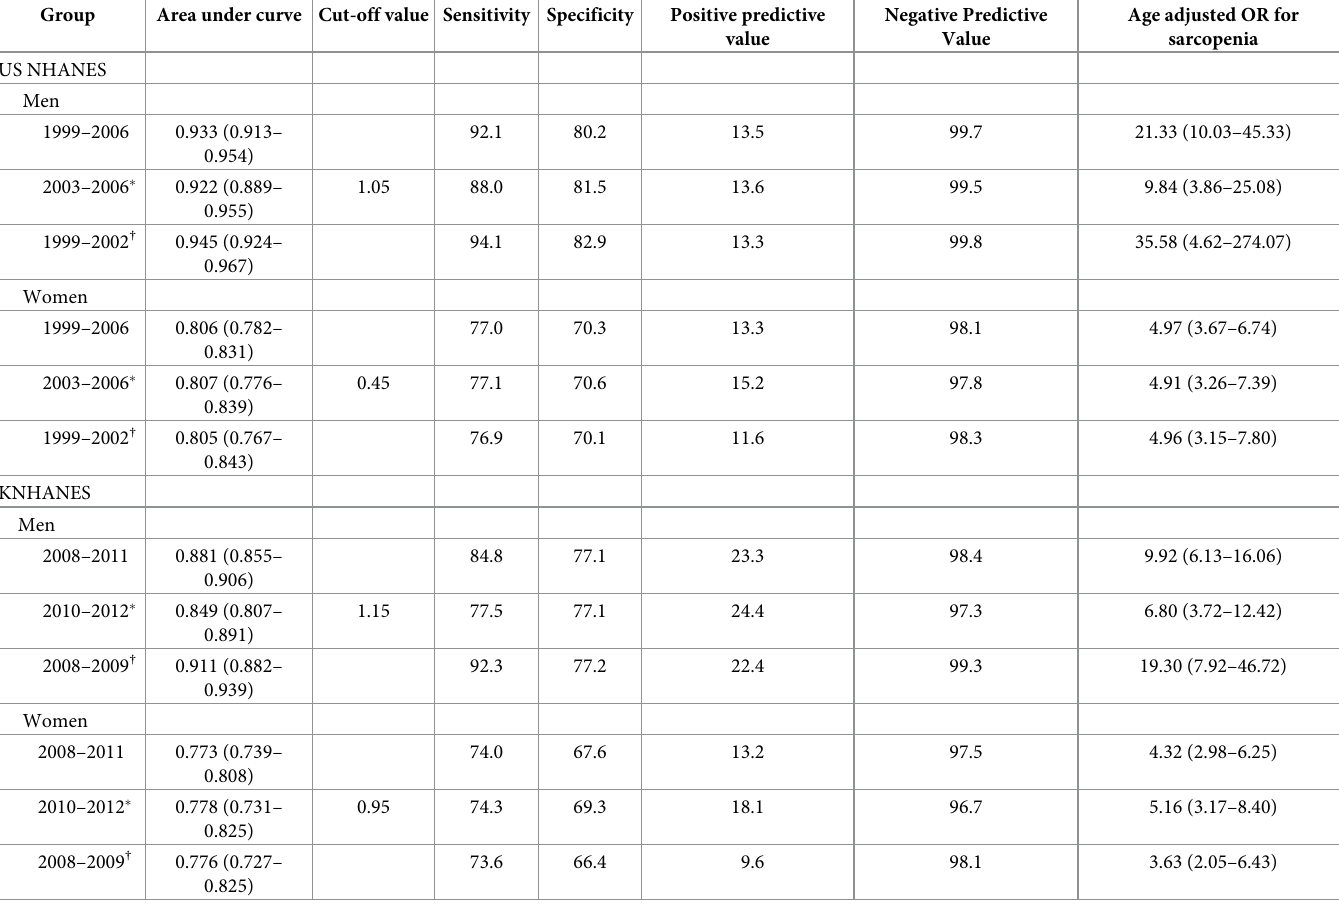
� Subset for developing the cut-off points. † Subset for validating the cut-off